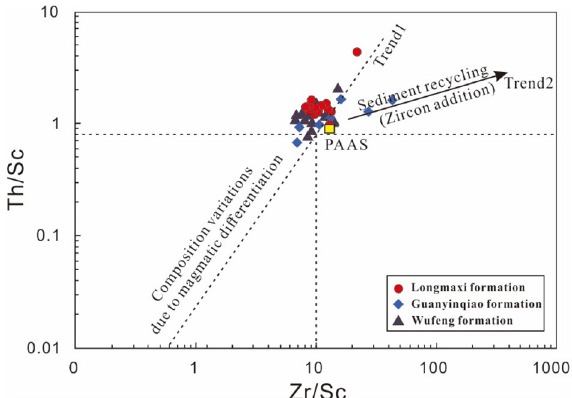
Figure 8. Th/Sc–Zr/Sc bivariate diagram of shales and carbonaceous marls to show their sediment recycling (McLennan et al. 62 ).